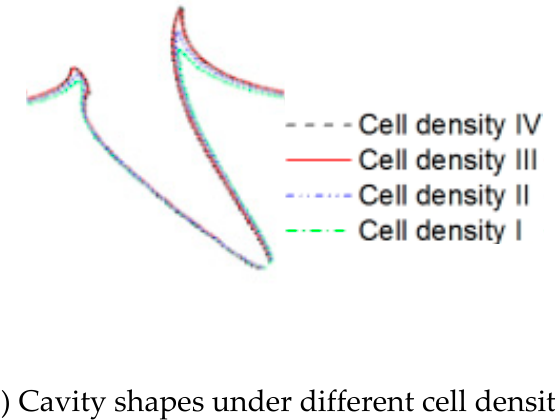
Figure 1. Problem illustration.